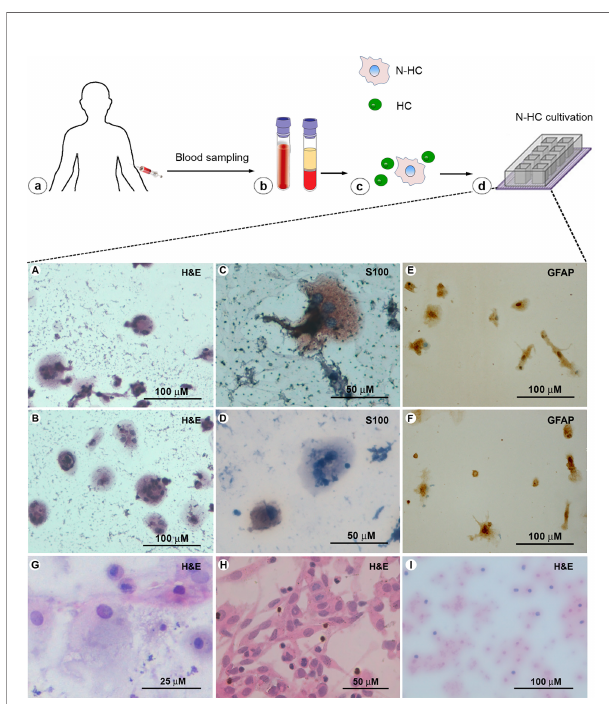
FIGURE 3 | Blood-derived glial cells in cytological preparations. (a) Peripheral blood sample collection. (b) Blood sample gradient. (c) From the gradient, a cellular suspension including non-haematological cells (N-HC) and residual of haematological cells (HC) was isolated. (d) The entire cell suspension was seeded in chamber slides and, after 14 days, adherent cells on slide were fi xed for cytological analysis. (A, B) H&E staining of CTCs deriving from the presented case shows different cellular shapes. (C, D) Immunostaining shows CTCs S-100 and (E, F) GFAP-positive deriving from the presented case. (G, H) Cytological pattern of CTCs derived from one glioblastoma and one cerebral metastasis from melanoma used as positive controls. (I) Cytological pattern of cells from a frontal lobe scar used as negative